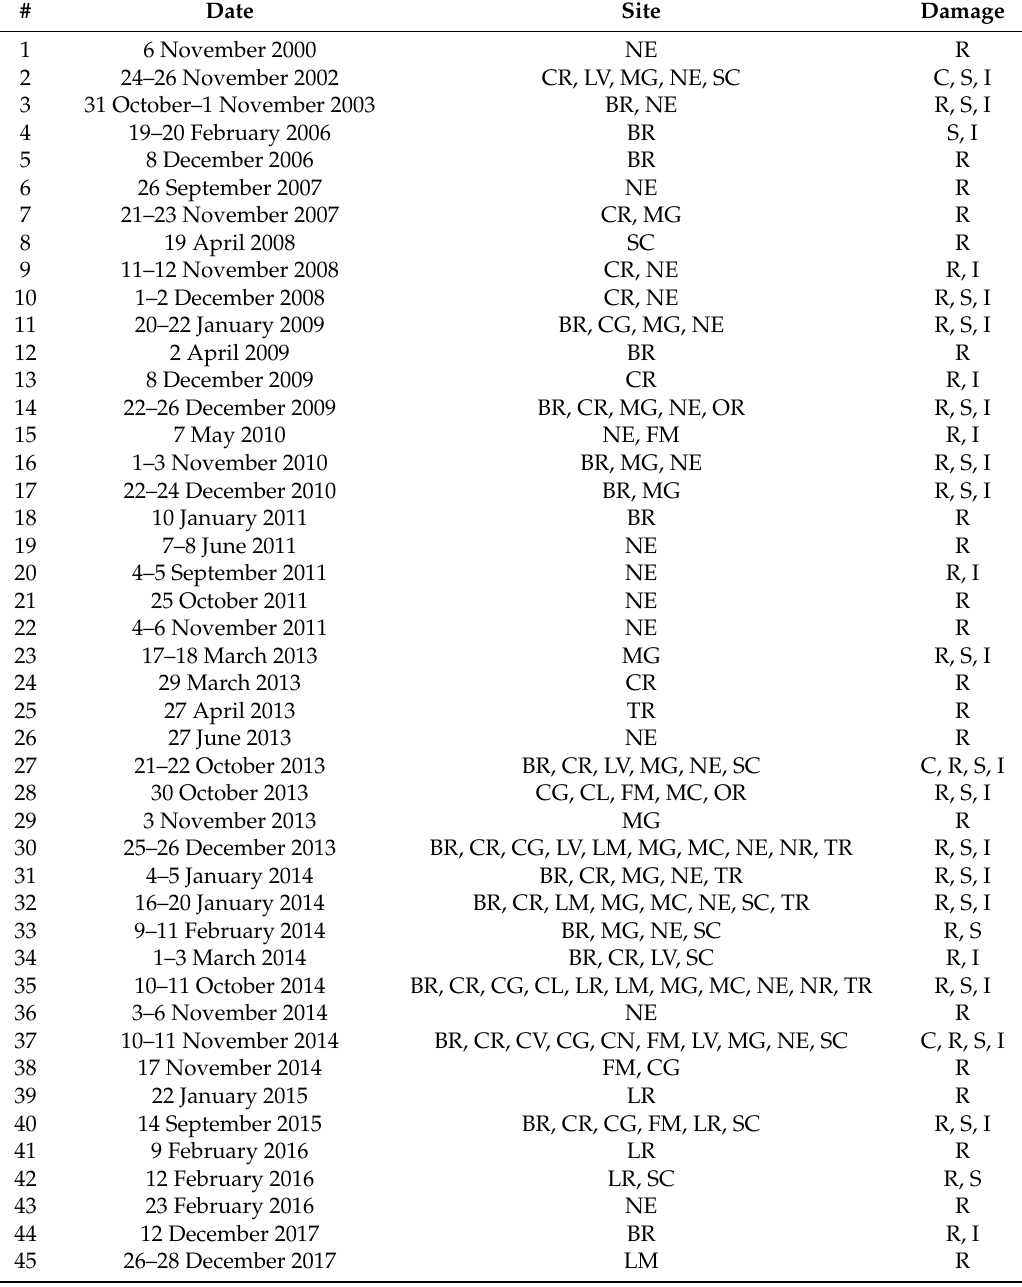
Table 2. Rainfall events that have caused shallow landslides and instability phenomena on the slopes in the Entella River basin in the 17-year period covering 2000–2017. Sites: BR, Borzonasca; CG, Cicagna; CR, Carasco; CV, Chiavari; CN, Cogorno; CL, Coreglia Ligure; FM, Favale di Malvaro; LM, Lumarzo; LR, Lorsica; LV, Leivi; MG, Mezzanego; MC, Moconesi; NE, Ne; NR, Neirone; OR, Orero; SC, San Colombano Certenoli; TR, Tribogna. See Figure 1 for location of the sites. Damaged element: B, building; I, infrastructure; R, road; S, structure; C,